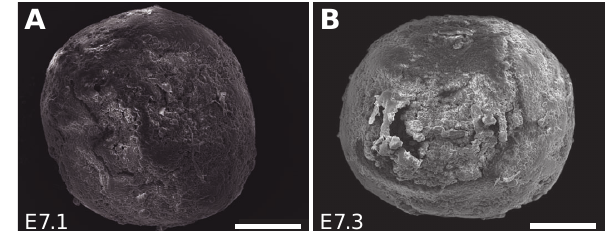
Fig. 5. SEM images of pre-heated crayfish eggs of E7.1 and E7.3 incubated under the same conditions. (A) After 1 week. (B) Af- ter 3 weeks. Complete preservation of the spherical morphology is evident and continuous mineralization occurs as fine-grained crys- tallites (scale bar: